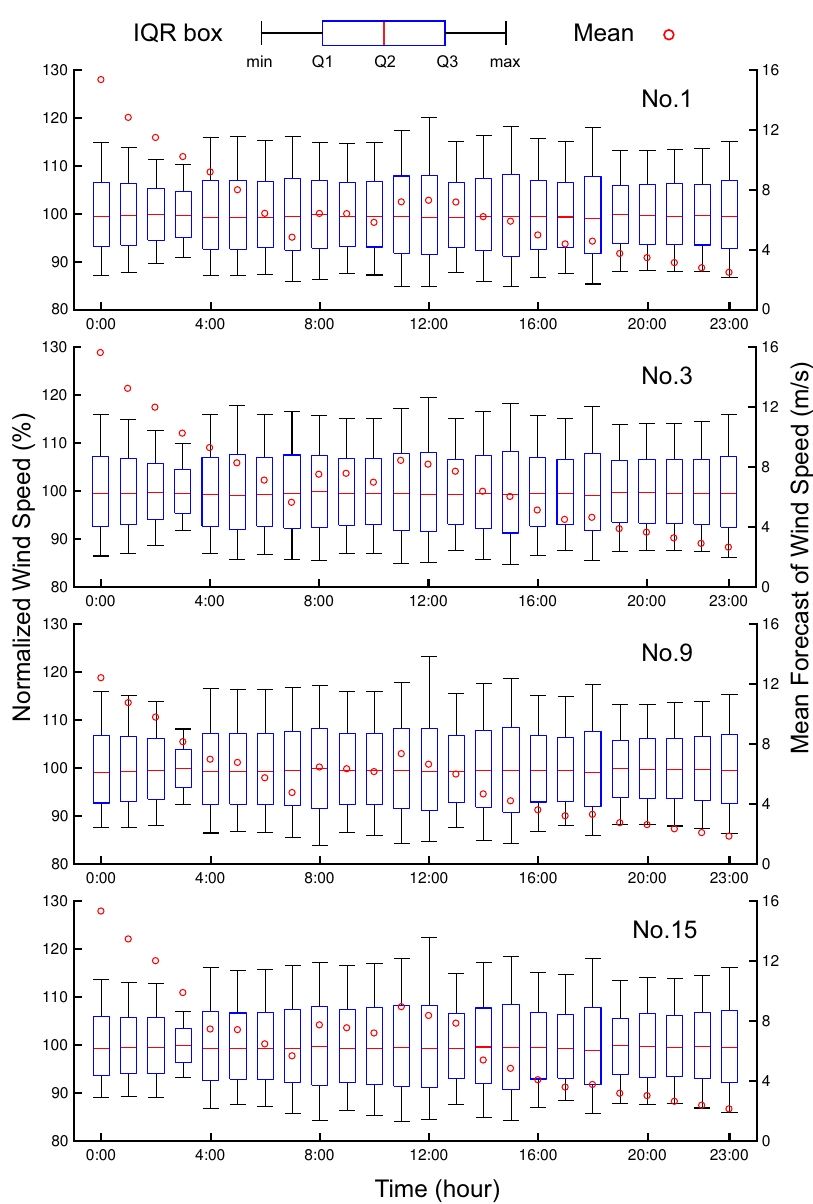
Figure 8. The interquartile range (IQR) boxes of the wind speed normalized by the mean values (left axis) in regard to the uncertainty in α for four turbines at 24 instants from 00:00 UTC 9 October to 23:00 UTC 9 October 2013. In each box, minimum, Q1, Q2, Q3, and maximum value stand for the CDF 0%, 25%, 50%, 75%, and 100%, respectively. The red circles indicate mean values of the wind speed forecasts (right axis) for each time